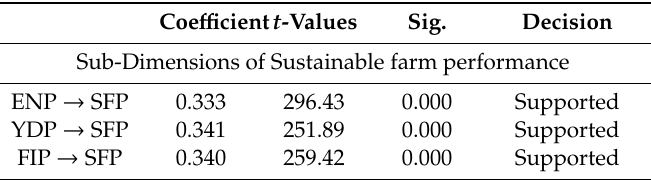
Table 3. Hierarchical Model of sustainable farm